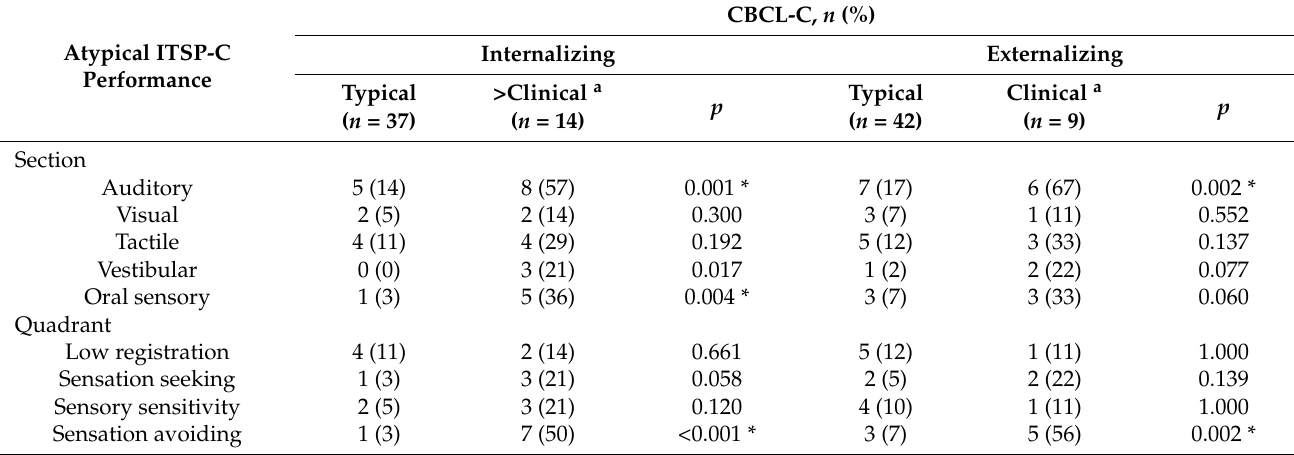
Table 3. The prevalence of atypical ITSP-C performance in late preterm children with and without behavioral problems.